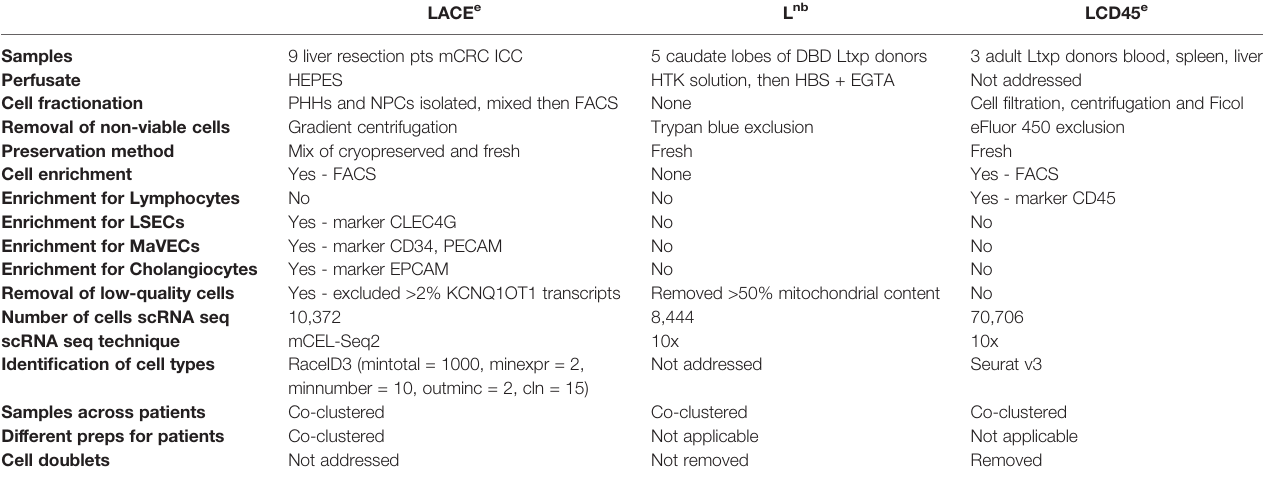
TABLE 1 | Comparison of methods from three peer-reviewed single cell RNA sequencing studies of the liver. LACE